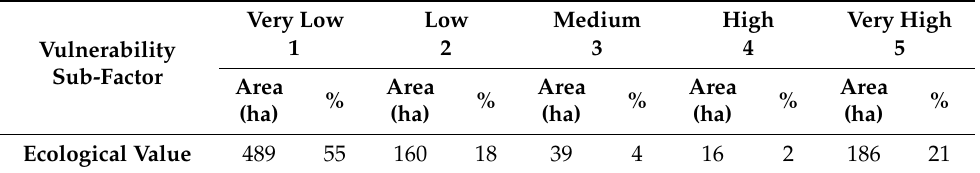
Table 32. Areas and percentages of the study area classified as each class of the ecological value vulnerability sub-factor.